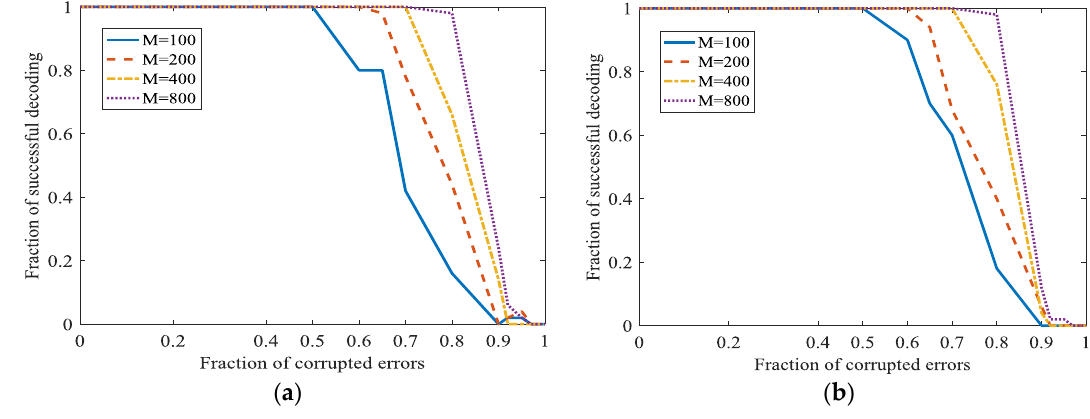
Figure 12. Error correction in L1 optimization at different ϑ when m / n decrease. ( a ) ϑ = 0.1; ( b )